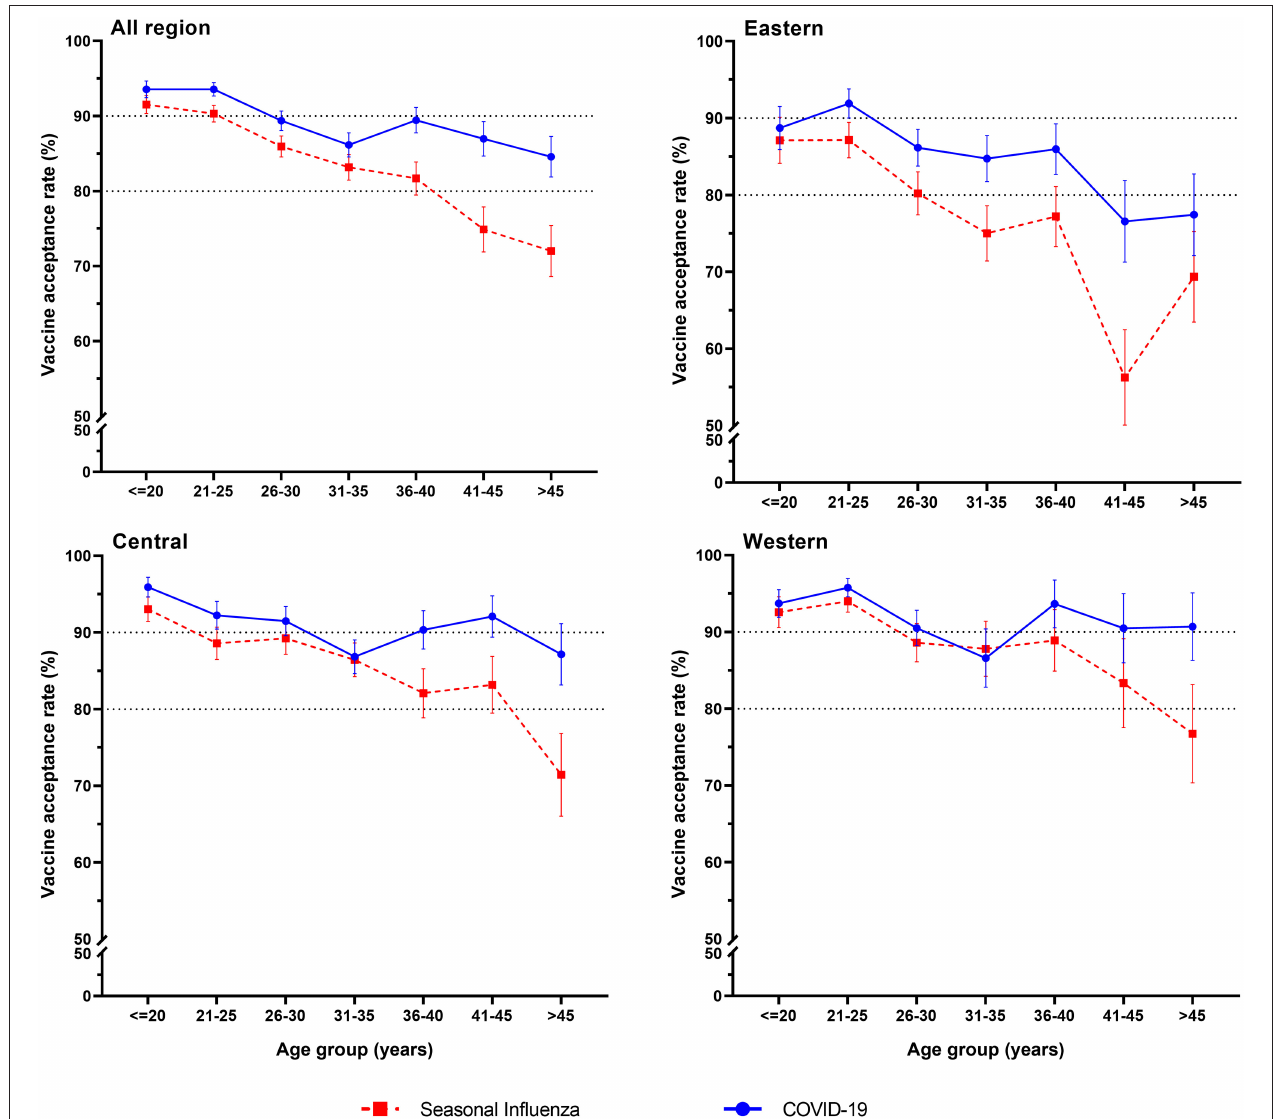
FIGURE 2 | COVID-19 and seasonal influenza vaccine acceptance rates by age groups and